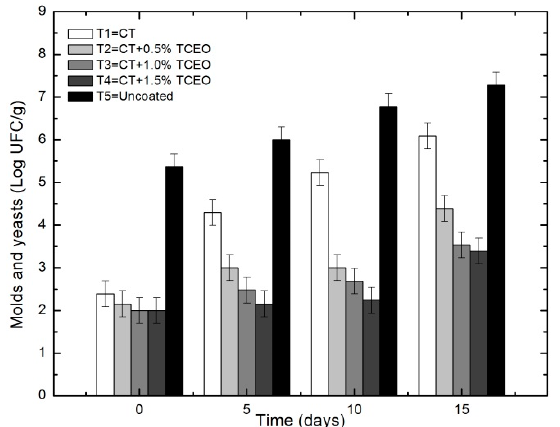
Figure 10. Counting of molds and yeasts in strawberries with chitosan (CT) and treatments of oil (TCEO): T1 = CT, T2 = CT + 0.5% of TCEO, T3 = CT + 1.0% of TCEO, T4 = CT + 1.5% TCEO, and T5 = uncoated. Mean values and intervals of Fisher’s LSD of 95% according to the ANOVA test.